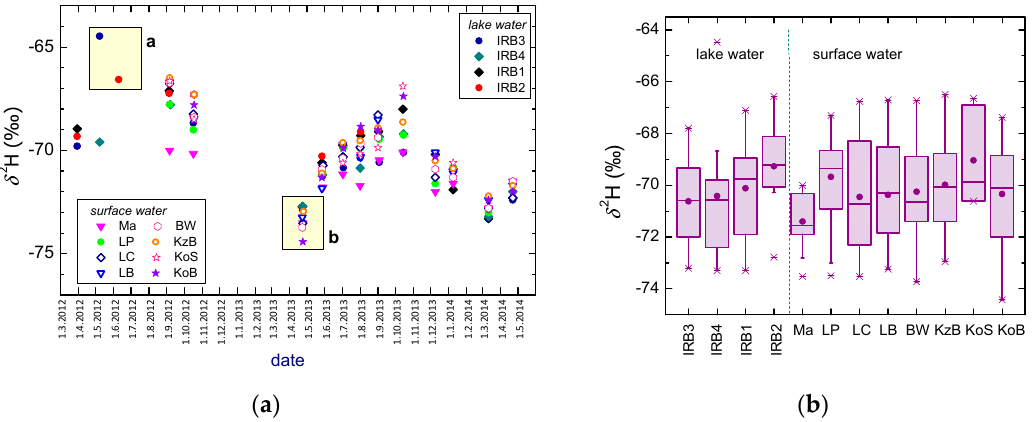
Figure 14. ( a ) Seasonal variation in the δ 2 H of surface and lake waters for 2012–2014. For an explanation of groups ( a , b ), see text. ( b ) Box-plots of δ 2 H values at the same locations.